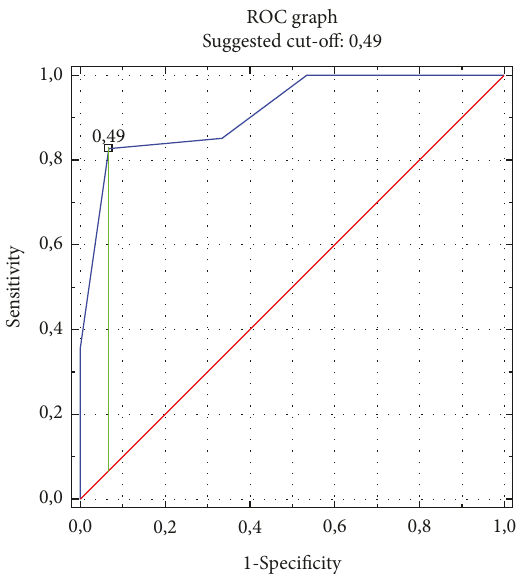
Figure 2: ROC curve for predicting left ventricular hypertrophy using the CTR value on the chest